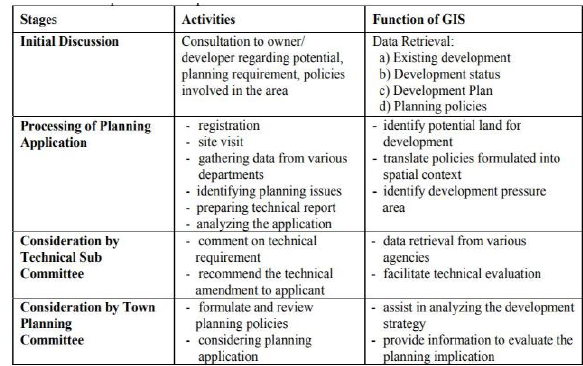
Figure 4: Example of self-procedure and GIS function at DBKL for DCP before 2007 (Foziah et al.,